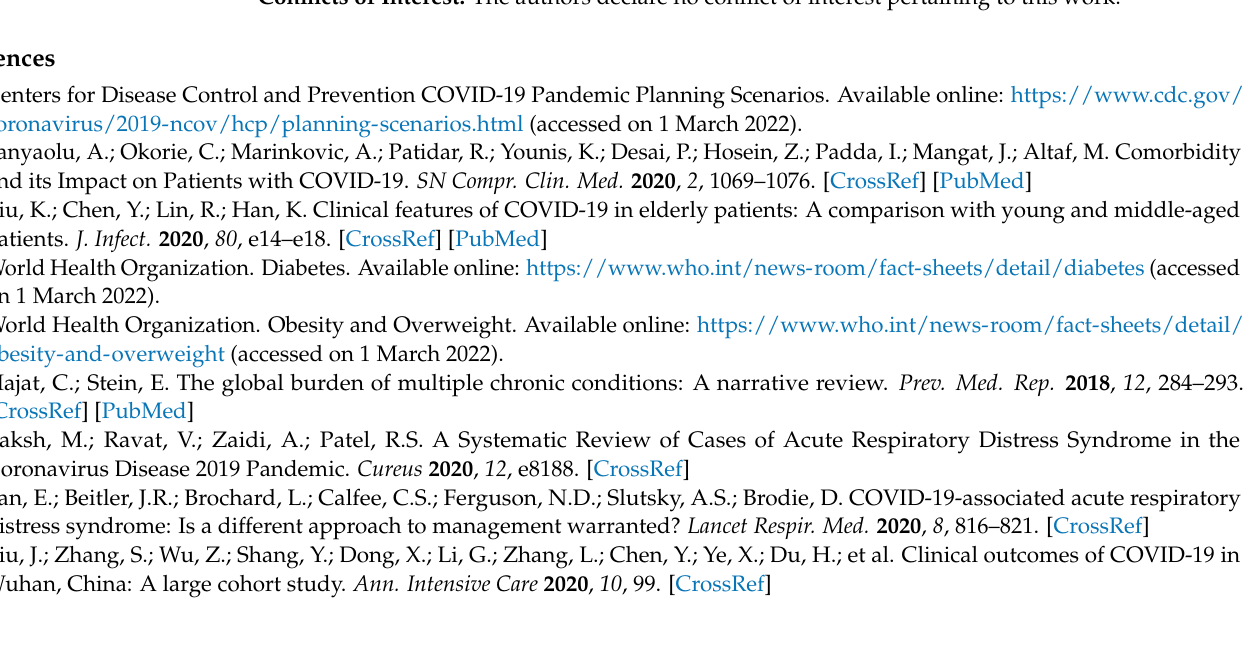
admission; Table S2: Logistic regression for clinical factors on admission and during the hospital stay; Figure S1: Flow